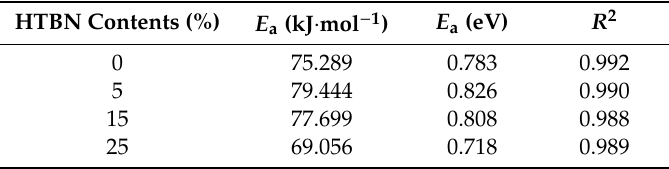
Table 3. Arrhenius equation fitting results of DC-conductivity.